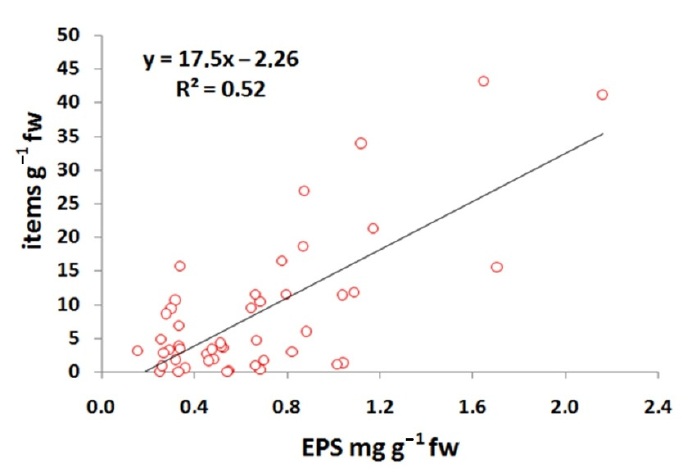
Figure 2. Boxplot with mean (round circles) of microplastic contamination in different species (combined data from all stations) from Venice lagoon (black) and Goro lagoon (blue).